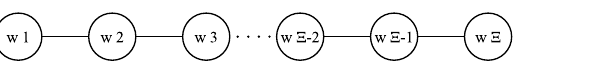
Figure 2. Swarm topology proposed for the one-dimensional solution